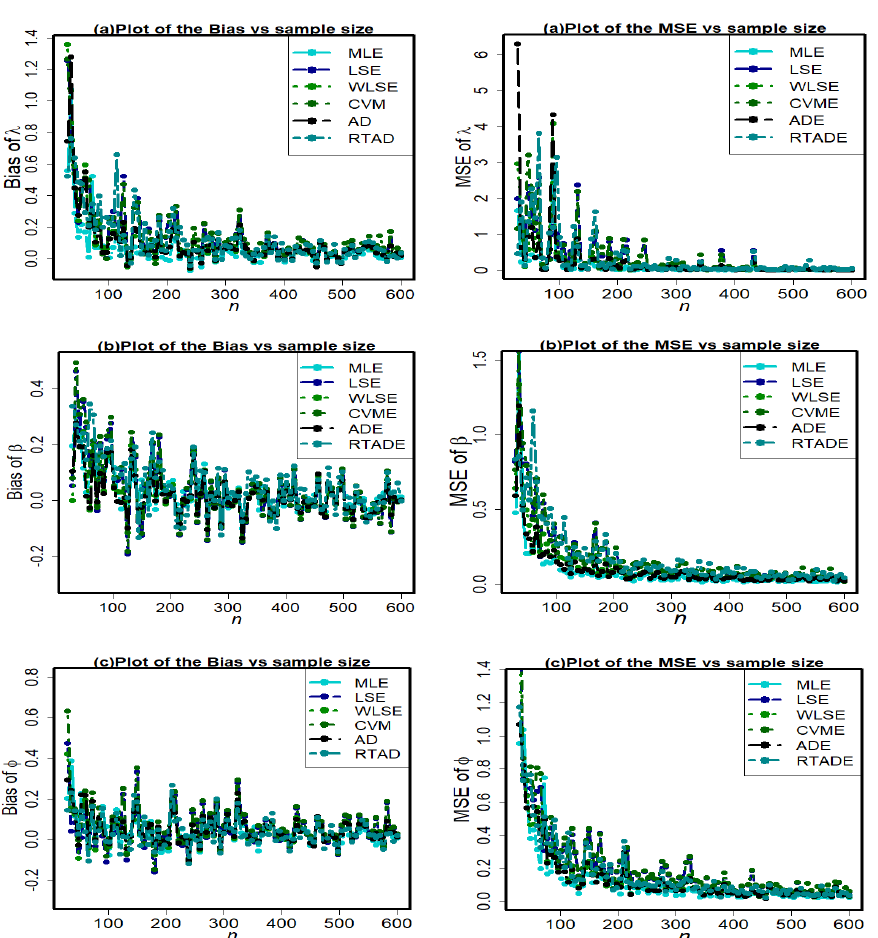
Fig. 10. Plots of biases and MSEs for the parameters (cid:21) = 1 : 9 ; (cid:12) = 2 : 3 and (cid:30) = 2 : 6 of HLUG-TI model.